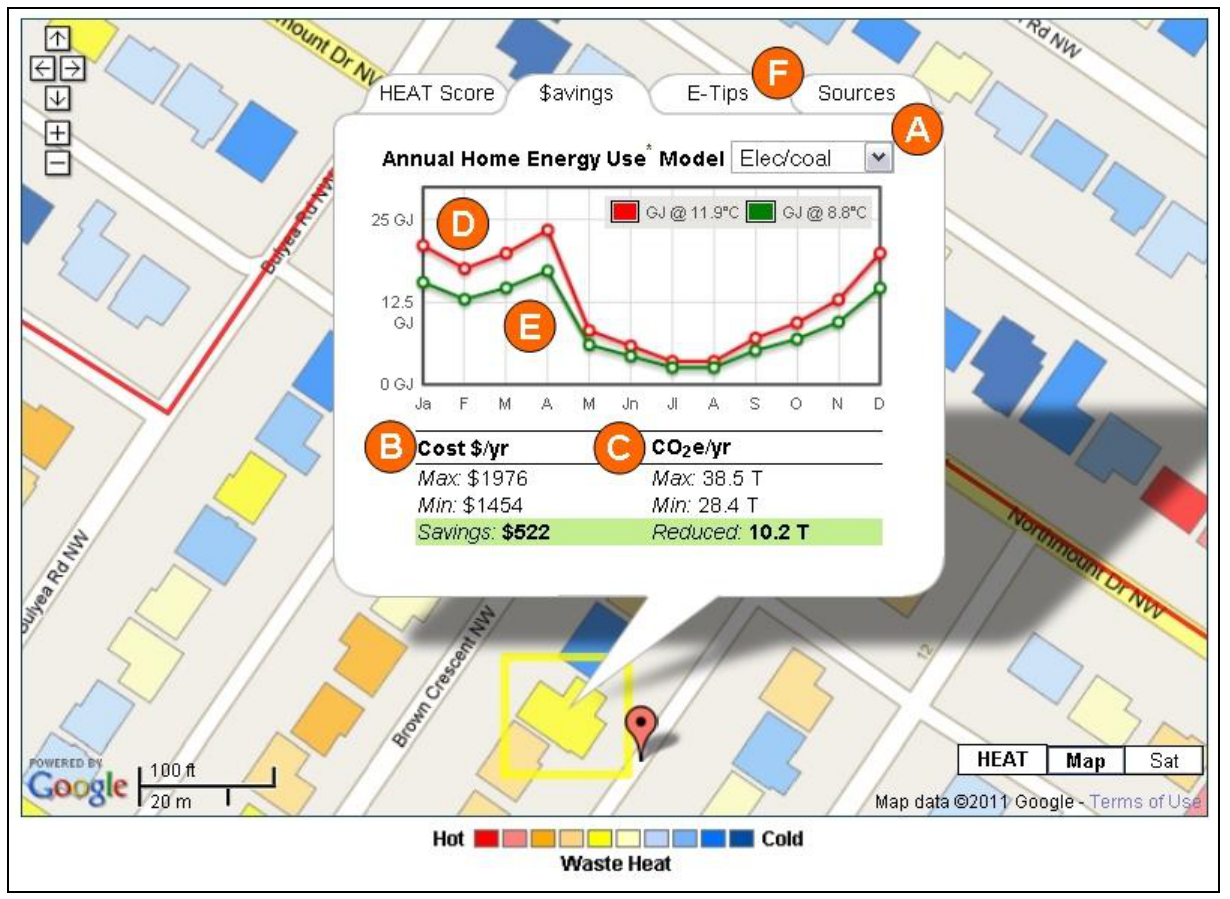
Figure 6. The $avings tab illustrates (A) , the Annual Home Energy Use Model which provides a yearly estimate of (B) , the money saved and (C) , the resulting CO if a home owner is able to reduce their waste heat from (D) , the maximum to (E) , the minimum roof temperature based on energy efficiency information located in E-Tips (F)